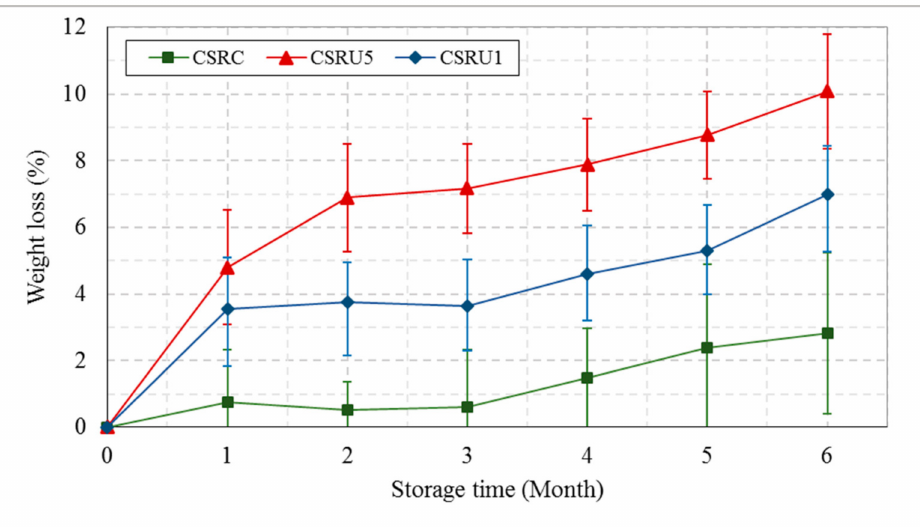
Figure 13. Comparison between the mean values of the weight loss of date fruits under different storage conditions of cold storage rooms and storage times. CSRC is the cold storage room with controlled RH at 80% and temperature of 5 ◦ C, CSRU5 is the traditional cold storage room with a temperature of 5 ◦ C, CSRU1 is the traditional cold storage room with a temperature of 1 ◦